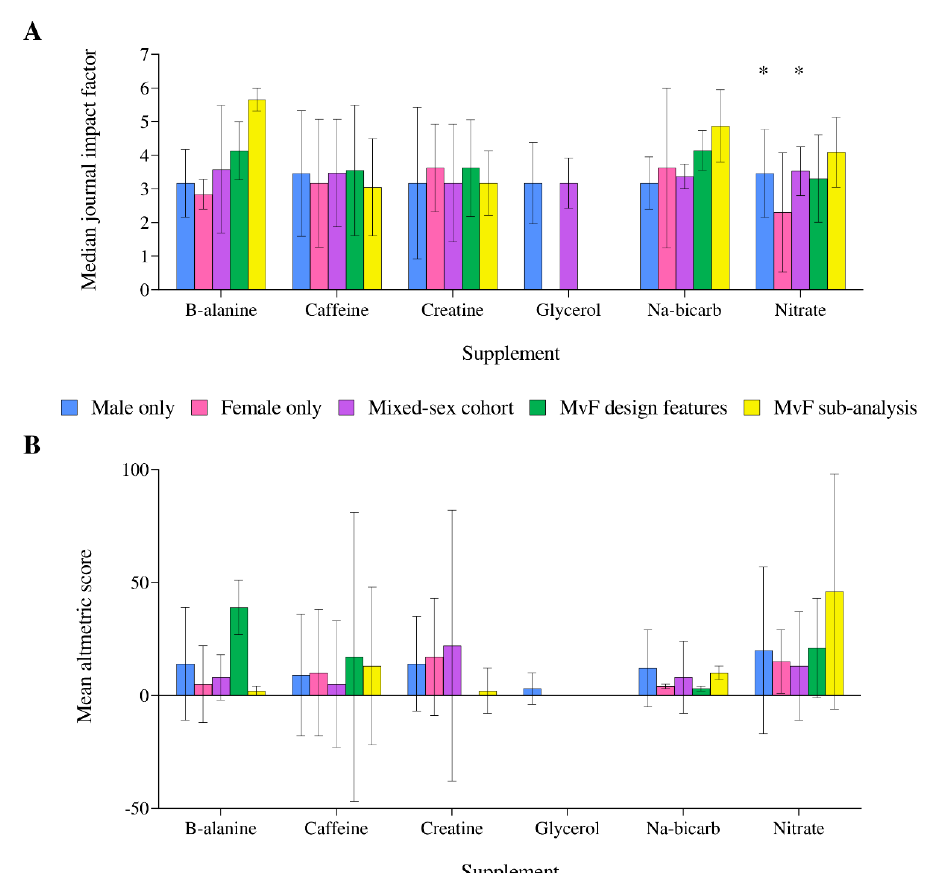
Figure 7. Median journal impact factor ( A ) and Altmetric score ( B ) across all performance supple- ments, separated by population studied. * Significantly greater impact factor compared to the nitrate studies in a female-only cohort ( p < 0.01). Error bars display the interquartile range. Male versus female